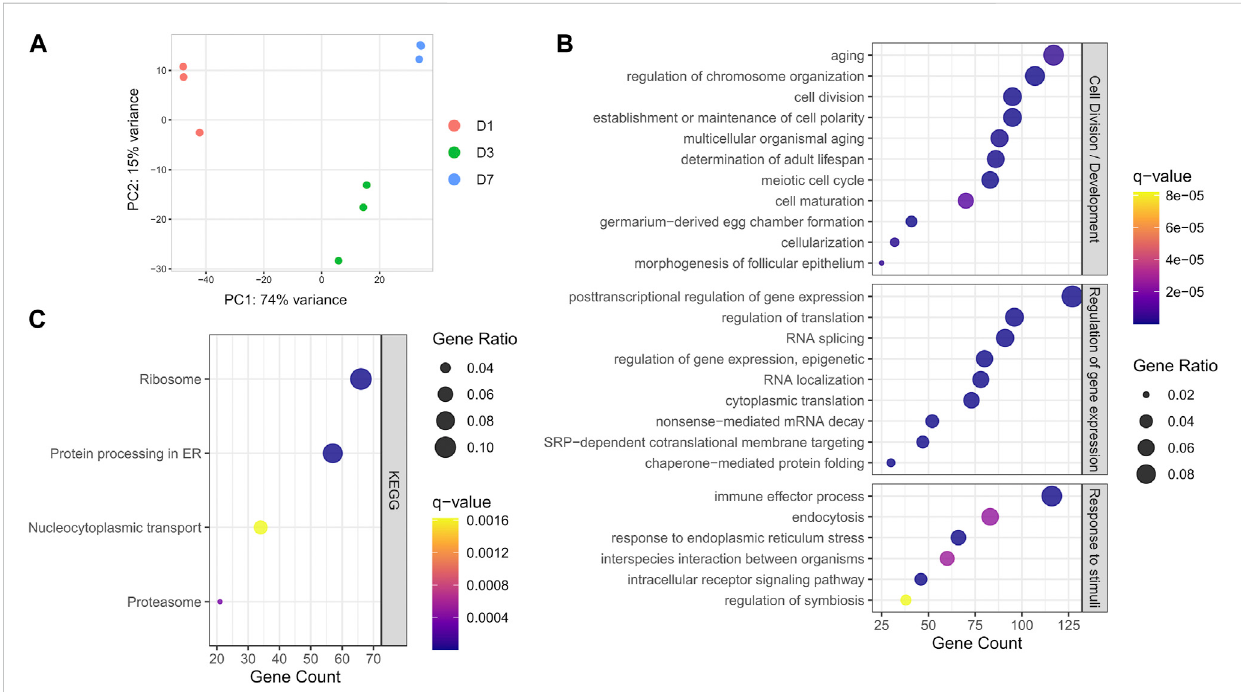
FIGURE 2 Global transcriptome analysis of S. oryzae germarium. (A) Principal component analysis (PCA) of normalized gene counts at day-one, -three and -seven(D1,D3,andD7)show distincttranscriptomesignatures. (B)